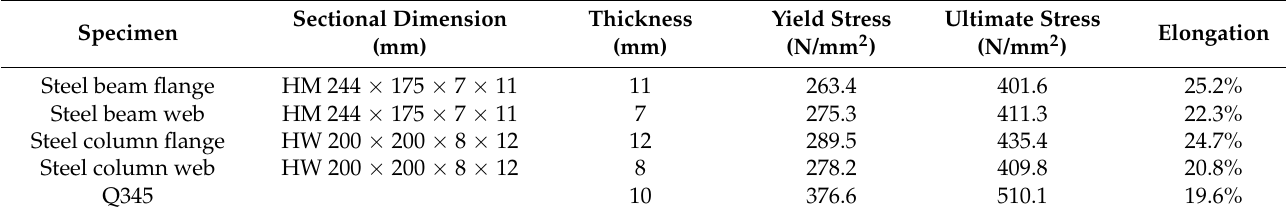
Table 2. Mechanical properties of steel.